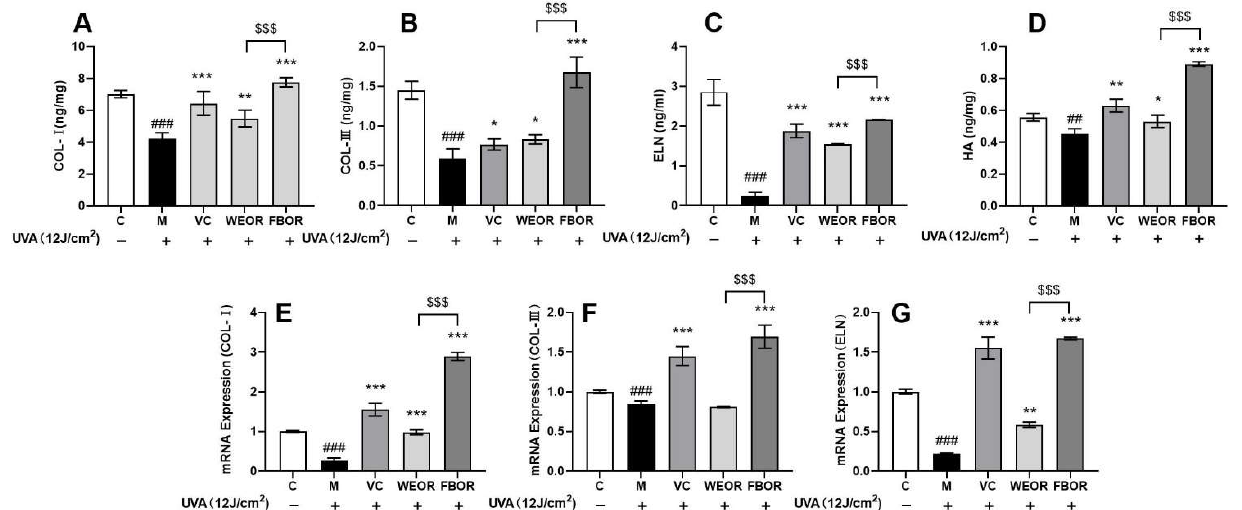
Figure 7. The effects of WEOR and FBOR on intracellular collagen and elastin content: ( A ) Type I collagen content; ( B ) Type 3 collagen content; ( C ) Elastin content; ( D ) Hyaluronic acid content; ( E ) Relative expression of type I collagen mRNA; ( F ) Relative expression of type III collagen mRNA; ( G ) Relative expression of elastin mRNA. (* p < 0.05, ** p < 0.01, *** p < 0.001, versus the UVB irradiation model group; ## p < 0.01, ### p < 0.001, versus the control group. $$$ p < 0.001, the WEOR group versus the FBOR group. C: Control group; M: UVB irradiation model group).